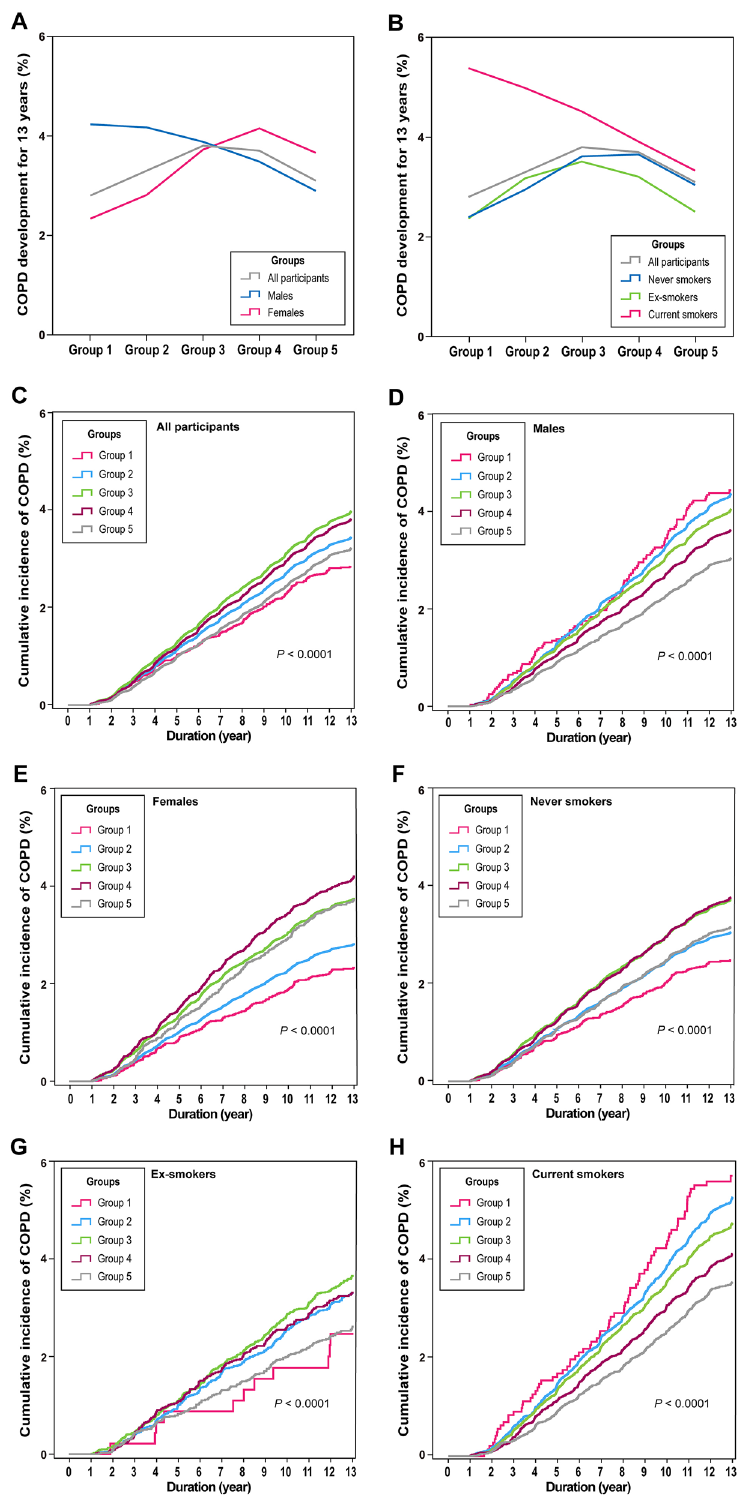
Figure 1. Prevalence and incidence of COPD development over 13 years. Prevalence of COPD development over 13 years according to sex (A) and smoking status (B) . Kaplan–Meier curves for the cumulative incidence of COPD development over 13 years according to the ALT group in all participants (C) , males (D) , females (E) , never smokers (F) , ex-smokers (G) , and current smokers (H) . ALT alanine aminotransferase, COPD chronic obstructive pulmonary disease. Adobe Illustrator version Creative Cloud was used to arrange the graphs and to add legends. (http:// www. adobe. com/ au/ produ cts/ illus trator.